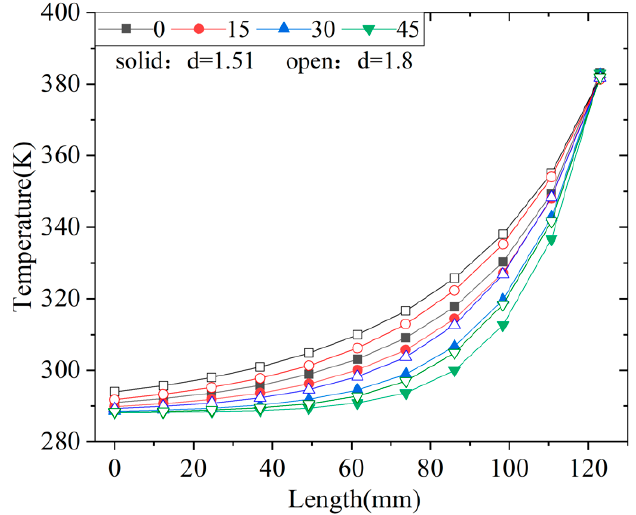
Figure 8. Temperature distribution of hot fluid with different channel diameter.